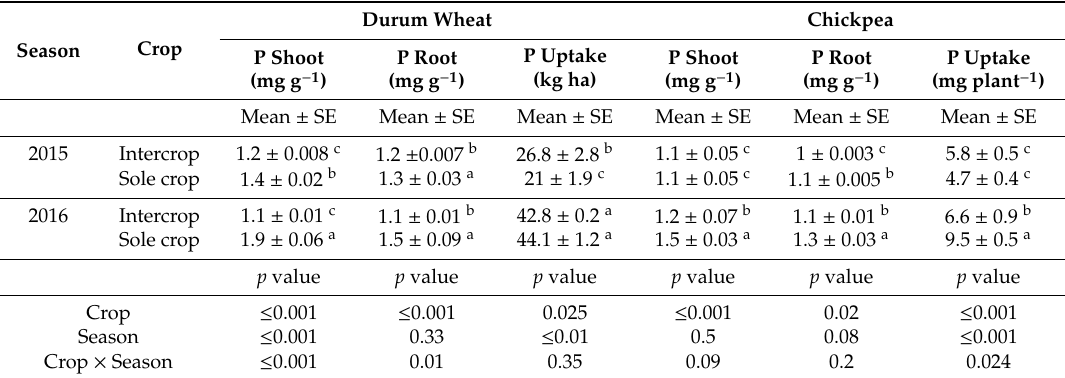
Table 2. Phosphorus concentration in shoots and roots and P uptake for whole plants for chickpea and durum wheat. Values represent the average of 10 replicates ± SE (standard errors). p -values from ANOVA (Cropping system, season, and cropping system ×